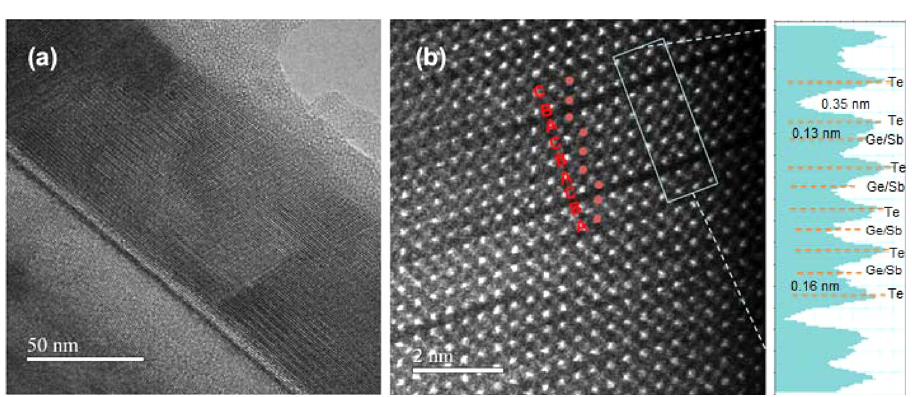
Figure 2. HAADF STEM micrograph of the GST on Si (111) annealed at 170 °C. ( a ) The texturing of the film is visible. In ( b ) the dark regions are vacancy layers with missing atoms, ordered according to a cubic stacking. The intensity profile on the right indicates a reduced distance between Te planes close to the vacancy layer, and the adjacent cationic